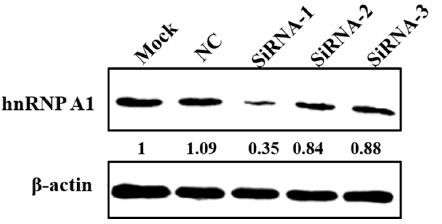
Figure 4. Silencing hnRNP A1 by siRNAs. CCL81 cells were transfected with no siRNA (Mock), negative control siRNA (NC), SiRNA-1, SiRNA-2 or SiRNA-3 at a concentration of 20 nM. Cells were collected at 60 h pt to analyze the expression of hnRNP A1 by western blot. HnRNP A1 protein levels were quantified by measuring band intensities and normalized with respect to the amount of β -actin. Viruses 2018 , 10 , x FOR PEER REVIEW